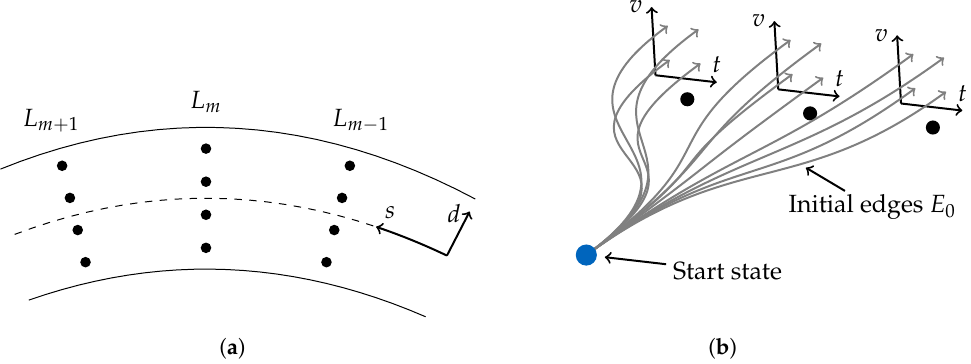
Figure 2. Used graph structure and initial edges. ( a ) Spatial nodes (black dots) of the graph are placed on layers perpendicular to the reference line (dashed line). ( b ) Initial edges E 0 connecting the start state to the initial layer L init in both the spatial and temporal